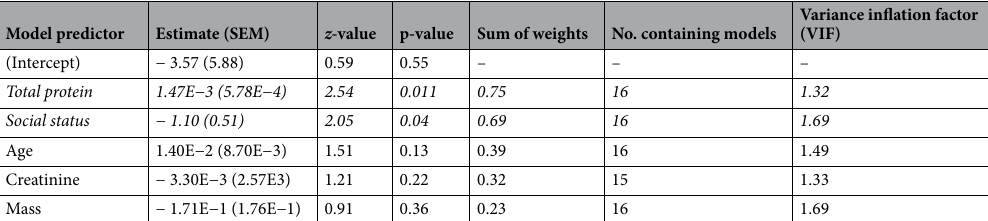
Table 1. Male reproductive success in response to urinary protein and social status. LME conditional model average for effects of male urine composition, age, mass, and social status during enclosures on RS (natural log transformed (1 + no. of offspring)). Table rows are ordered by predictor importance based on the sum of weights. Significant predictors are italicized. PC ratio omitted due to high VIF value suggesting collinearity (see Supplementary Table S1 for full